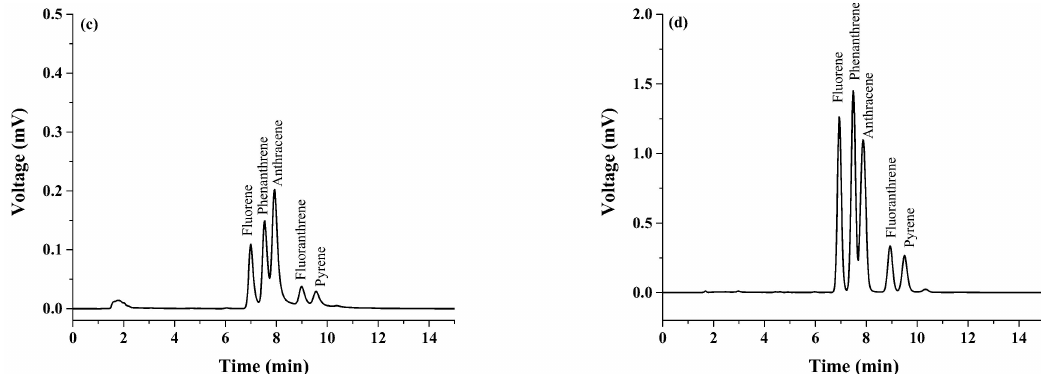
Figure 7. Chromatograms of ( a ) grilled pork sample, ( b ) grilled pork sample spiked with 0.01 mg · kg − 1 of each polycyclic aromatic hydrocarbon, ( c ) grilled pork sample spiked with 0.05 mg · kg − 1 of each polycyclic aromatic hydrocarbon, and ( d ) grilled pork sample spiked with 0.10 mg · kg − 1 of each polycyclic aromatic